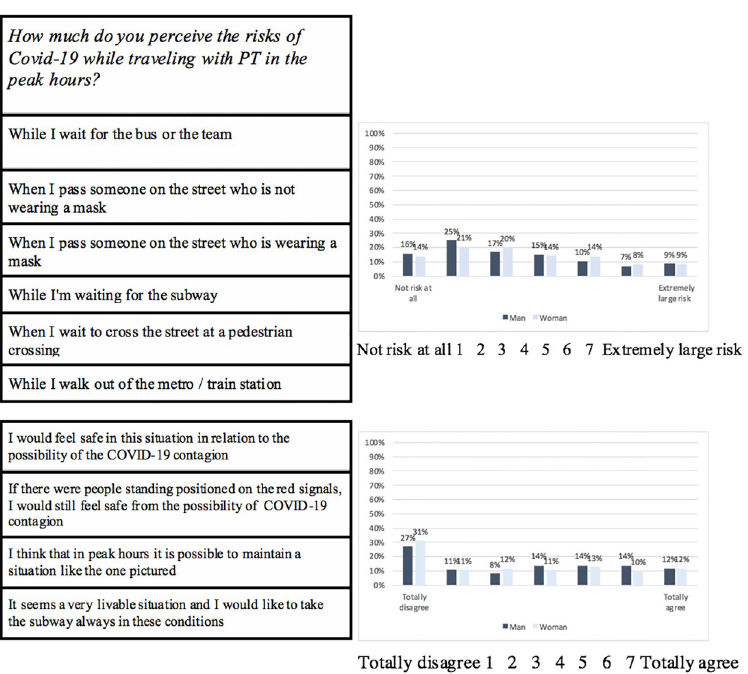
Fig 2. Distribution of risk perception evaluation for the two subscales. The distribution of each single item follows the distribution of each subscale.